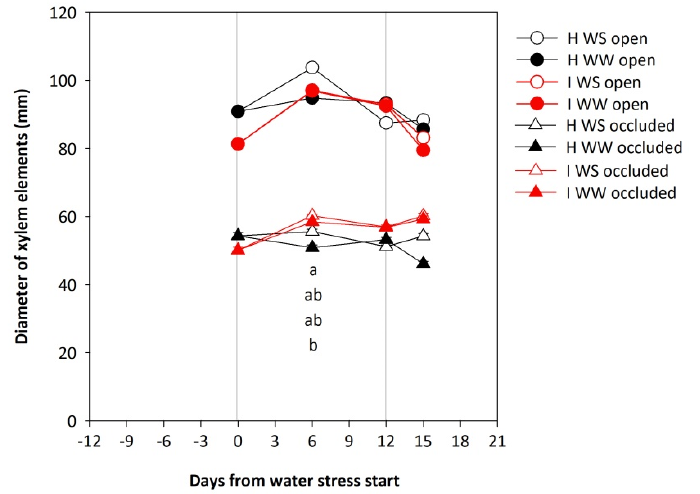
Figure 3. Diameter of xylem elements of potted own-rooted grapevines of cv. Schioppettino before the water stress, during the water stress, and after the recovery. Plants are separated regarding to plant health and water status: well-watered healthy (H WW), well-watered GFLV-infected (I WW), water-stressed healthy (H WS) and water-stressed GFLV-infected (I WS) plants. Error bars represent standard errors. For each time point separately, data were processed through ANOVA (significance reported in Supplementary Table S1), and means were separated with a Student Newman Keuls test ( p < 0.05; different letters represent significant differences between means). Grey lines represent the beginning and the end of water stress period.